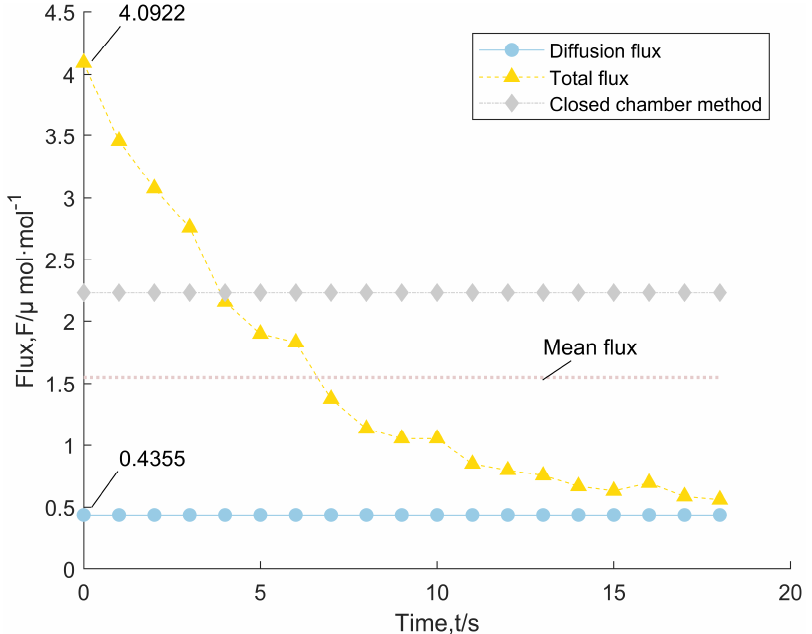
Figure 9. Pressure difference decay curve between O1 and O5 layers of sandy loam and the concen- tration change curve of O1 layer. The CO 2 concentration of O1 surface layer increases accordingly with the decay of pressure difference.